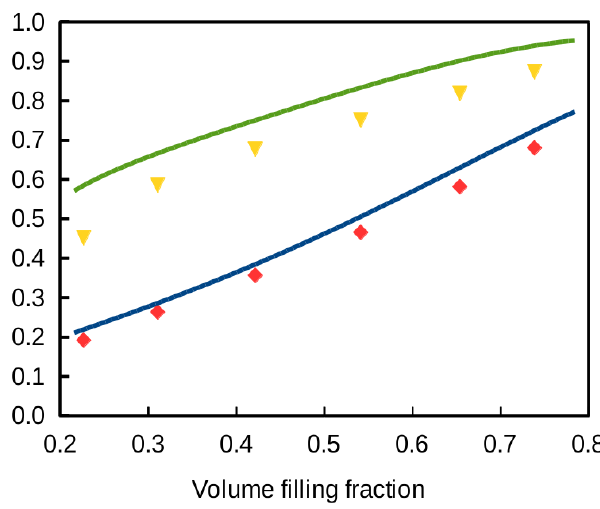
Figure 11. Thermal properties of the P-Schwarz lattice versus filling fraction when the conductivity of air is one tenth of that of the skeleton. Blue and green curves: relative conductivity κ e / κ m predicted by Equation (2) and the corresponding thermal conductivity efficiency χ (Equation (7)); red diamonds: κ e / κ m from full numerical calculations; yellow triangles: χ from full numerical